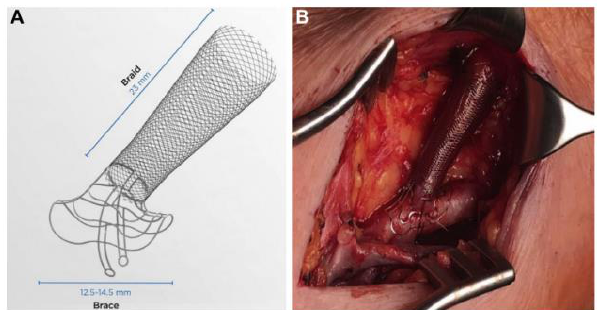
Figure 3 . ( A ) The VasQ device is composed of a brace and a mesh braid. ( B ) An in vivo view of the device implanted over the anastomotic region of a brachiocephalic AVF. Images are reprinted, with permission, from Karydis et al. (2020) [50].